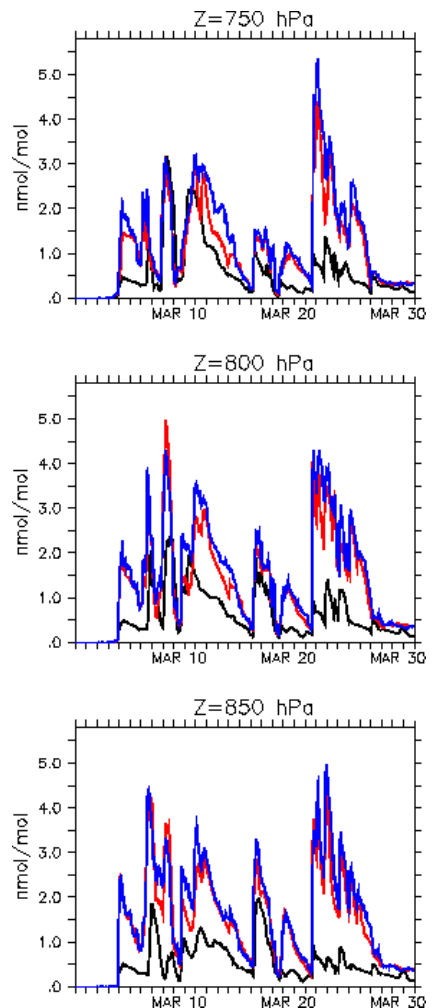
Fig. 9. Maximum mixing ratio (nmol/mol) of tracer PNT. The maximum is calculated in a rectangle ranging from 5 ◦ W to 25 ◦ E and 36 ◦ to 56 ◦ N. The mixing ratios are displayed at three different pressure levels: 850, 900 and 950 hPa. The injection height is 900 hPa. The ECHAM5/MESSy result is displayed in black. The red and the blue lines show the maximum mixing ratios of the COSMO-40 and COSMO-7 domains, respectively.